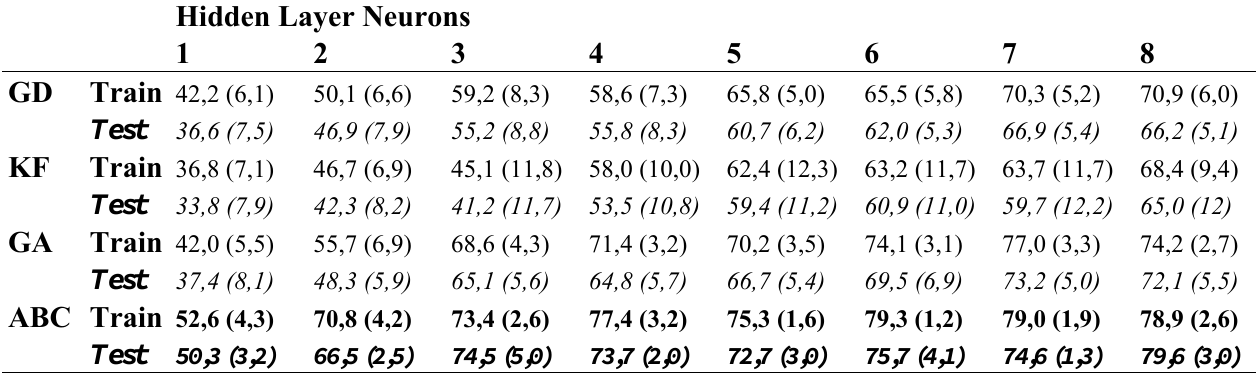
Table 7. Statistical PCCS results of Terrain Classification